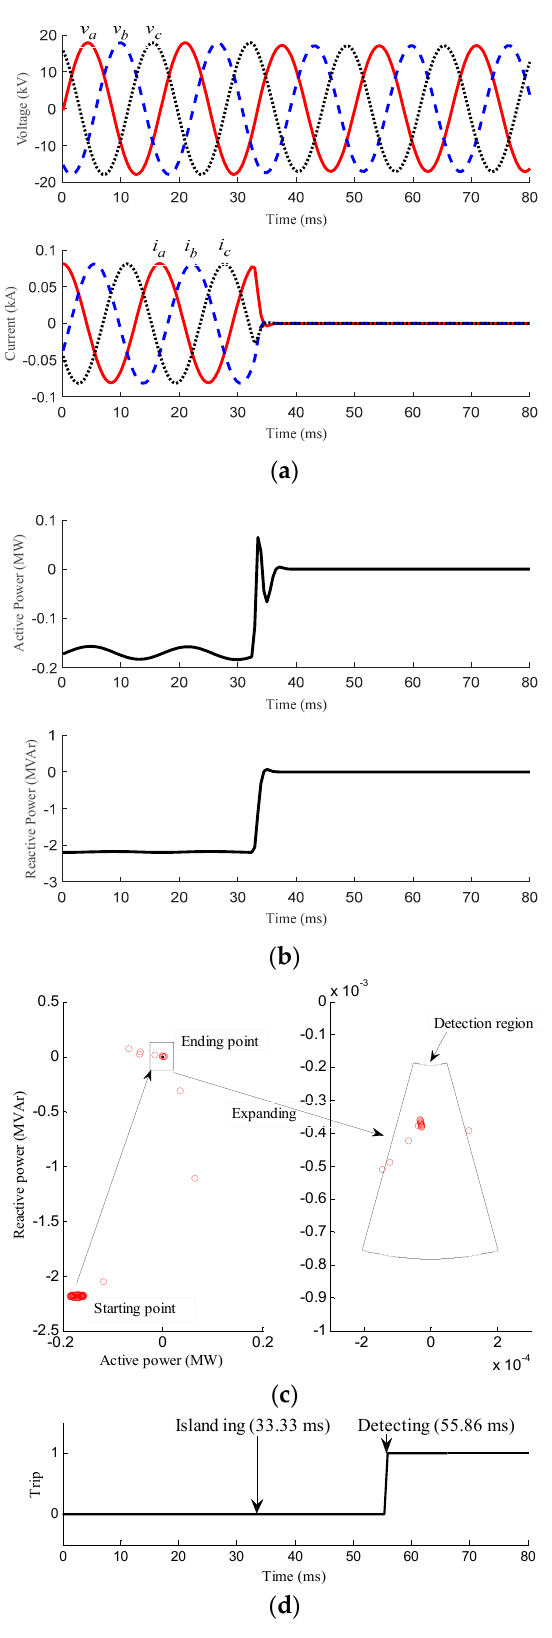
Figure 3. Results for Case 1. ( a ) v a , b , c (upper) and i a , b , c (lower); ( b ) p 3 ph (upper) and q 3 ph (lower); ( c ) Trajectories of the point ( p 3 ph , q 3 ph ); ( d ) Islanding detection signal.